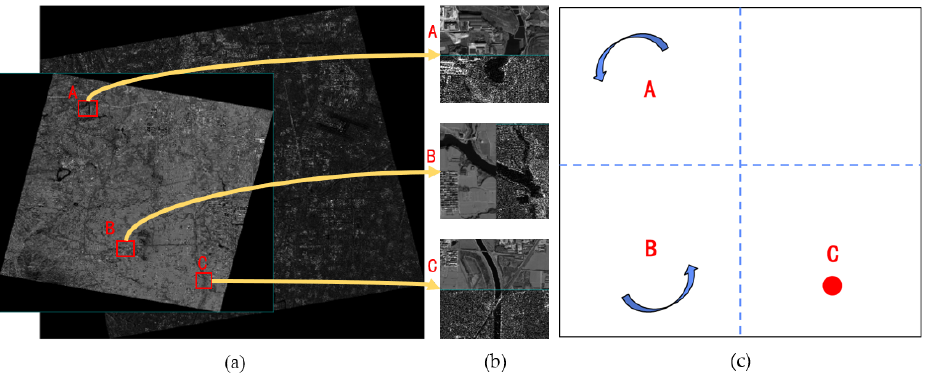
Figure 1. An example of the nonlinear deformation between optical and SAR images. ( a ) GF7 (visible), GF3 (SAR). ( b ) Details of the nonlinear deformation. ( c ) The transformer of the optical and SAR images pair. The image pair have a significant nonlinear deformation which is not satisfied the affine